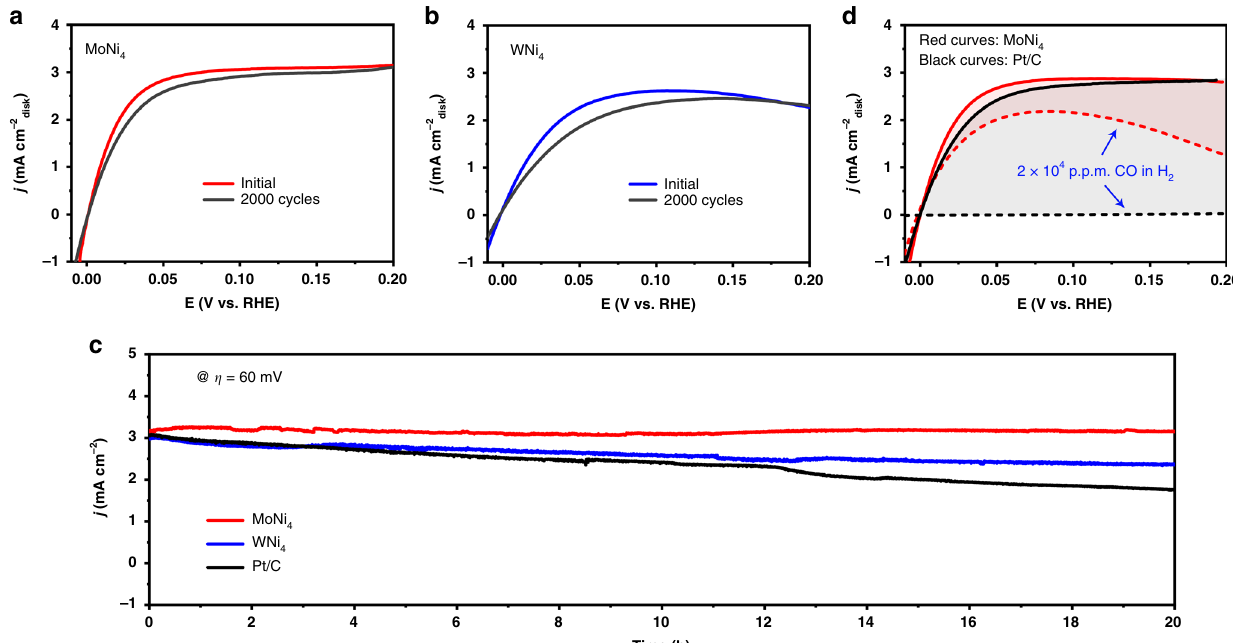
Fig. 4 Performance stability and CO resistance. a , b HOR polarization curves for MoNi 4 and WNi 4 alloys in H 2 -saturated 0.1 M KOH before and after 2000 cycles, respectively. c Chronoamperometry ( j – t ) responses recorded on MoNi 4 , WNi 4 , and Pt/C catalysts at a 60 mV overpotential in H 2 -saturated 0.1 M KOH. d HOR polarization curves for MoNi 4 and Pt/C alloys in H 2 -saturated 0.1 M KOH with (dashed lines) and without (solid lines) the presence of 20,000p.p.m.